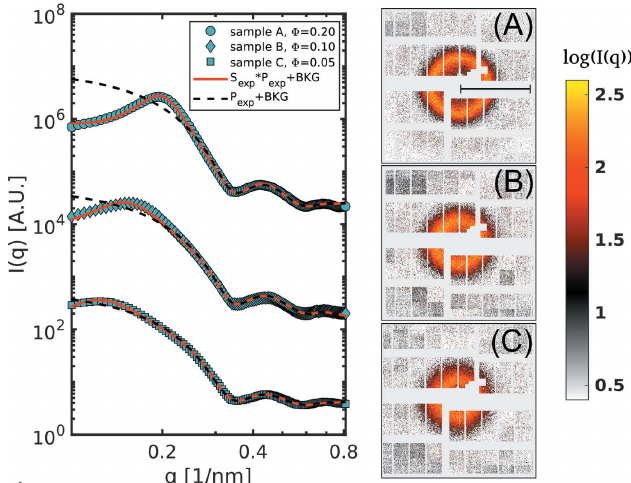
Figure 2 Structural information for the three samples A, B and C. Cyan points: scattered intensity I exp ( q ), black dashed lines: form factor, red lines: I ( q ) fitted with Equation (8). For clarity, the curves are multiplied by a factor. On the right-hand side, single-shot speckle patterns from the three samples are reported. In order to highlight the speckles, a median filter has been applied to the images. The AGIPD is not optimized for SAXS- XPCS experiments, due to the presence of large gaps between the modules and the necessity to mask large areas of the detector. Nevertheless, it is still possible to obtain high-quality data owing to the high repetition rate of this device. The black bar in the pattern (A) indicates a distance of 0.5 nm (cid:2) 1 in the scattering